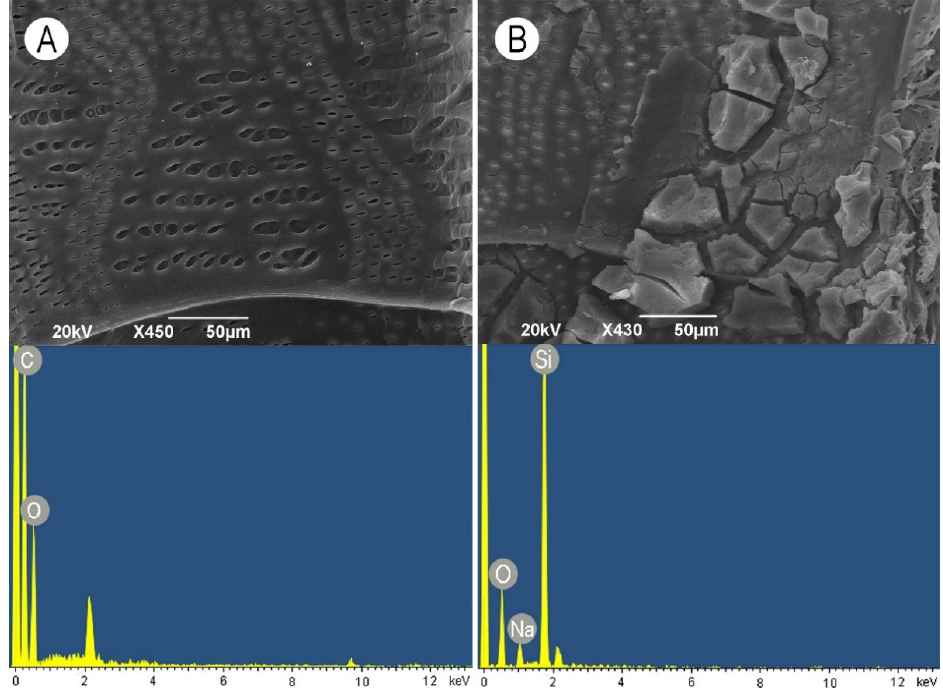
Figure 6. Scanning electron microscopy images of earlywood vessel wall surfaces (upper images) accompanied with the representative EDX spectra showing the elemental composition (bottom images). ( A ) Untreated control oak wood, radial section, scale bar = 50 μ m. ( B ) Treatment with the aqueous solution of water glass, tangential section, scale bar = 50 μ m.